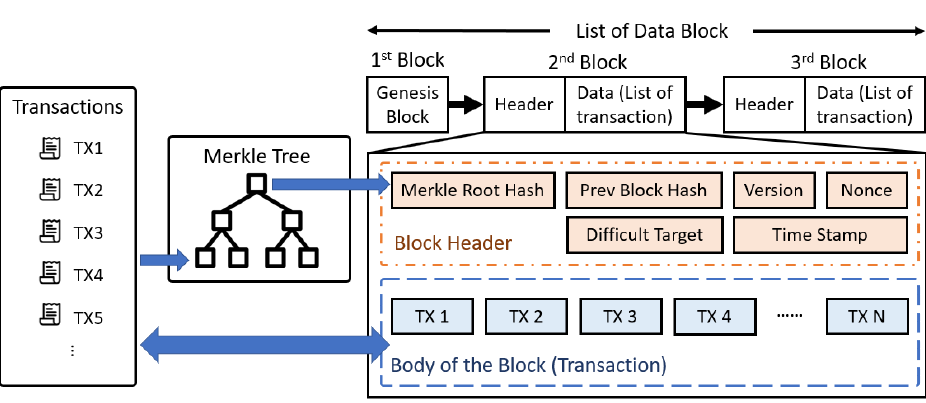
Figure 7. Inter-Planetary File System (IPFS) fingerprint as the transactions in the blockchain (leaves of Merkle tree).